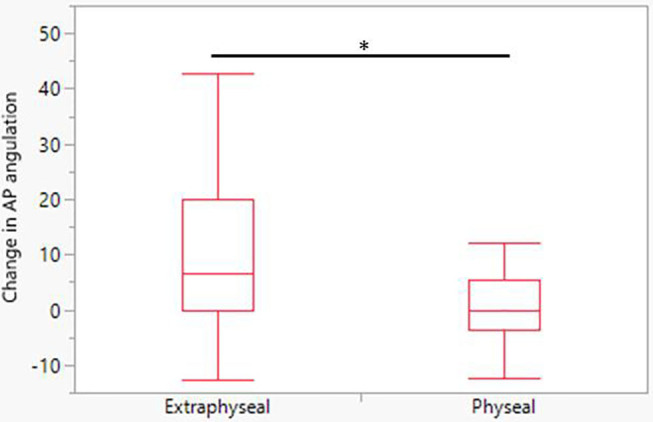
Change in AP radiograph angulation at final follow up. Extraphyseal fractures have significantly greater change in angulation measured at final follow up. * = P < 0.01.